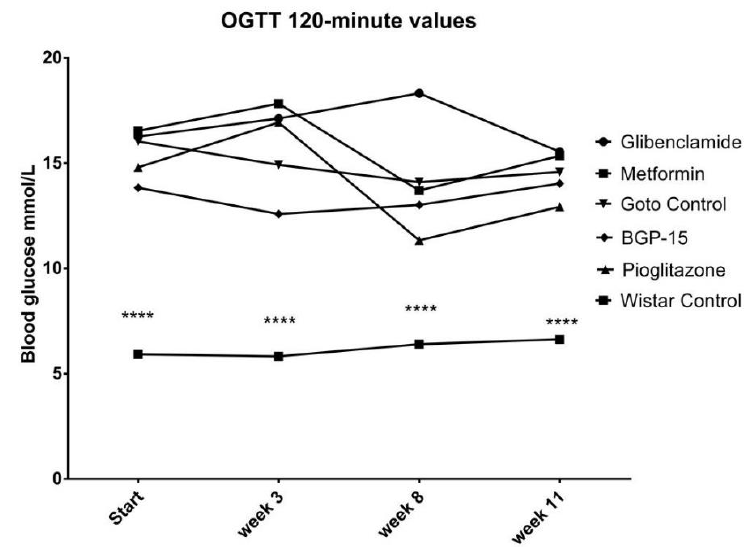
Figure 6. Blood glucose values of the different animal groups at the end of OGTTs (120 min after glucose load). Data is presented as group mean. For a better visibility, standard error of the mean (SEM) of each data points are not plotted. n = 6 animals in each group. **** p < 0.0001 compared to all other groups. Statistical analysis was done using GraphPad Prism: data was analysed with two-way analysis of variance (ANOVA) test.